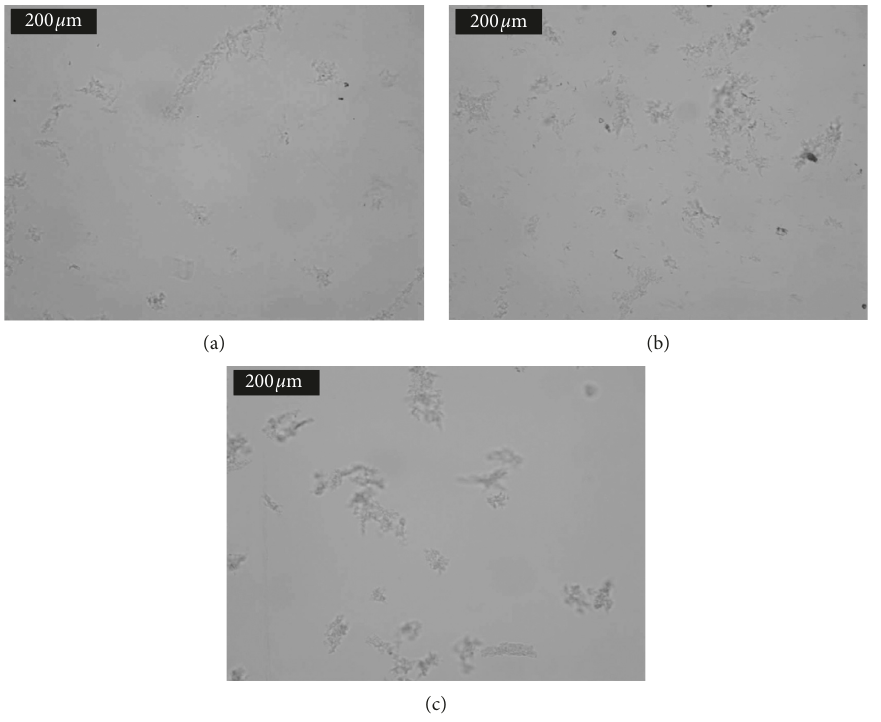
Figure 8: Morphology of the AA/CS hydrogel at ratios: (a) 50, (b) 12, and (c) 5.